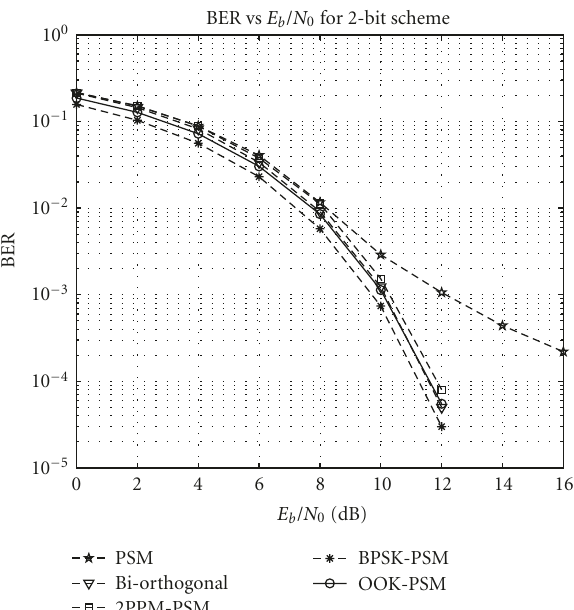
Figure 6: Performance of PSM, BPSM, PPM-PSM, BPSK-PSM, and OOK-PSM for 2-bit symbols transmission scheme for modified Hermite pulses in AWGN.